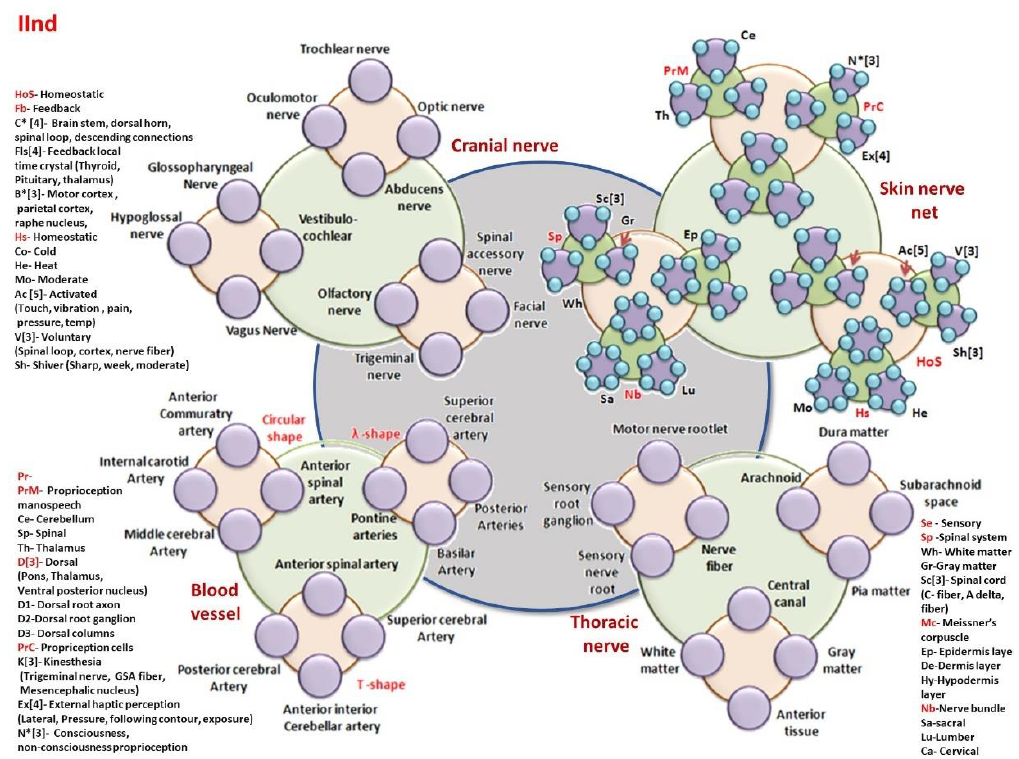
Figure 12. Four brain components Skin nerve network, cranial nerve network, Blood vessels and thoracic nerve system. Information 2020 , 11 , x FOR PEER REVIEW 27 of 49